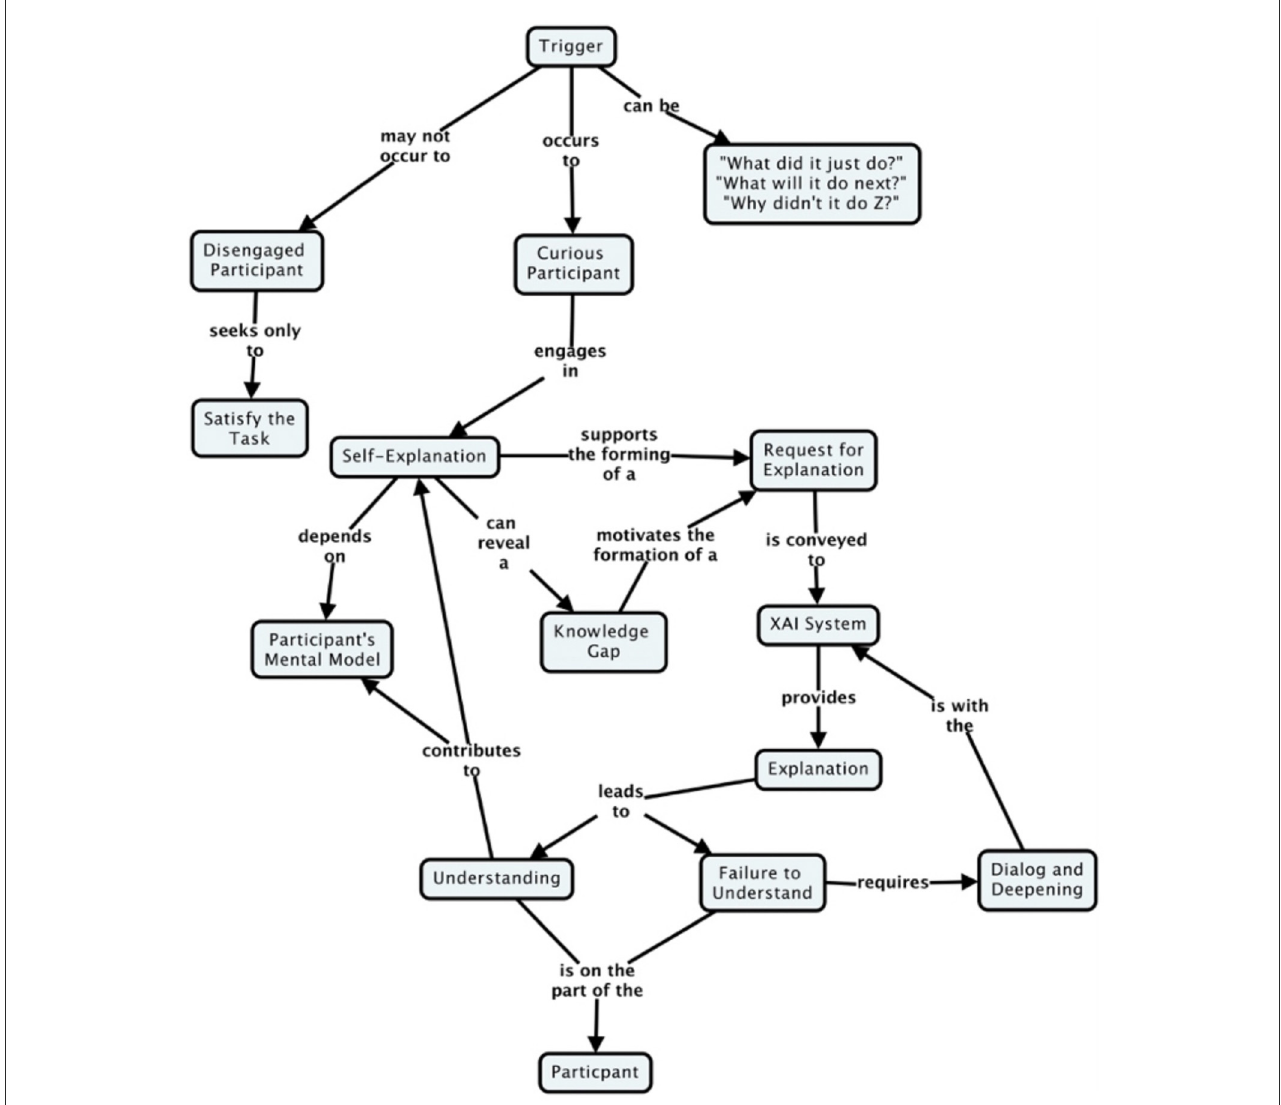
FIGURE2 A model of the explanation process in the XAI context from the perspective of the learner, showing the role of curiosity.